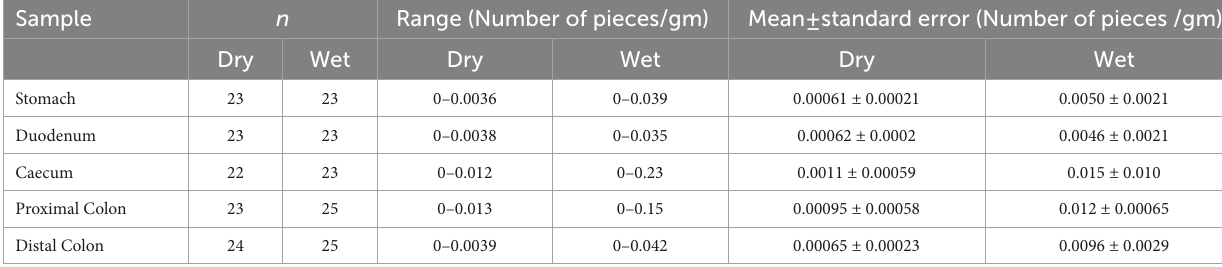
TABLE 2 Concentration of microplastic pieces throughout the GI